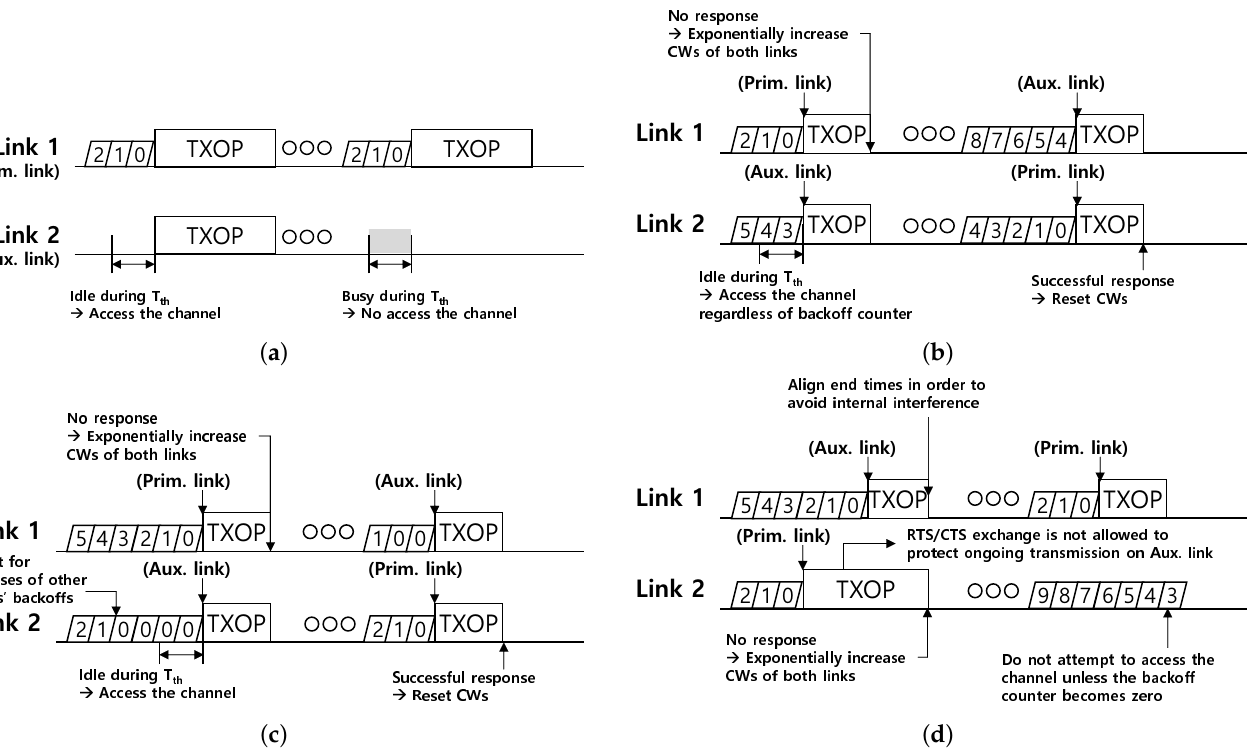
Figure 4. Illustrations of synchronous multi-link DCFs for supporting non-STR multi-link devices (MLDs). ( a ) Single-link access (SLA), ( b ) multi-link access with the shortest backoff (MLA-S), ( c ) multi-link access with the longest backoff (MLA-L), ( d ) multi-link access with end-time alignment